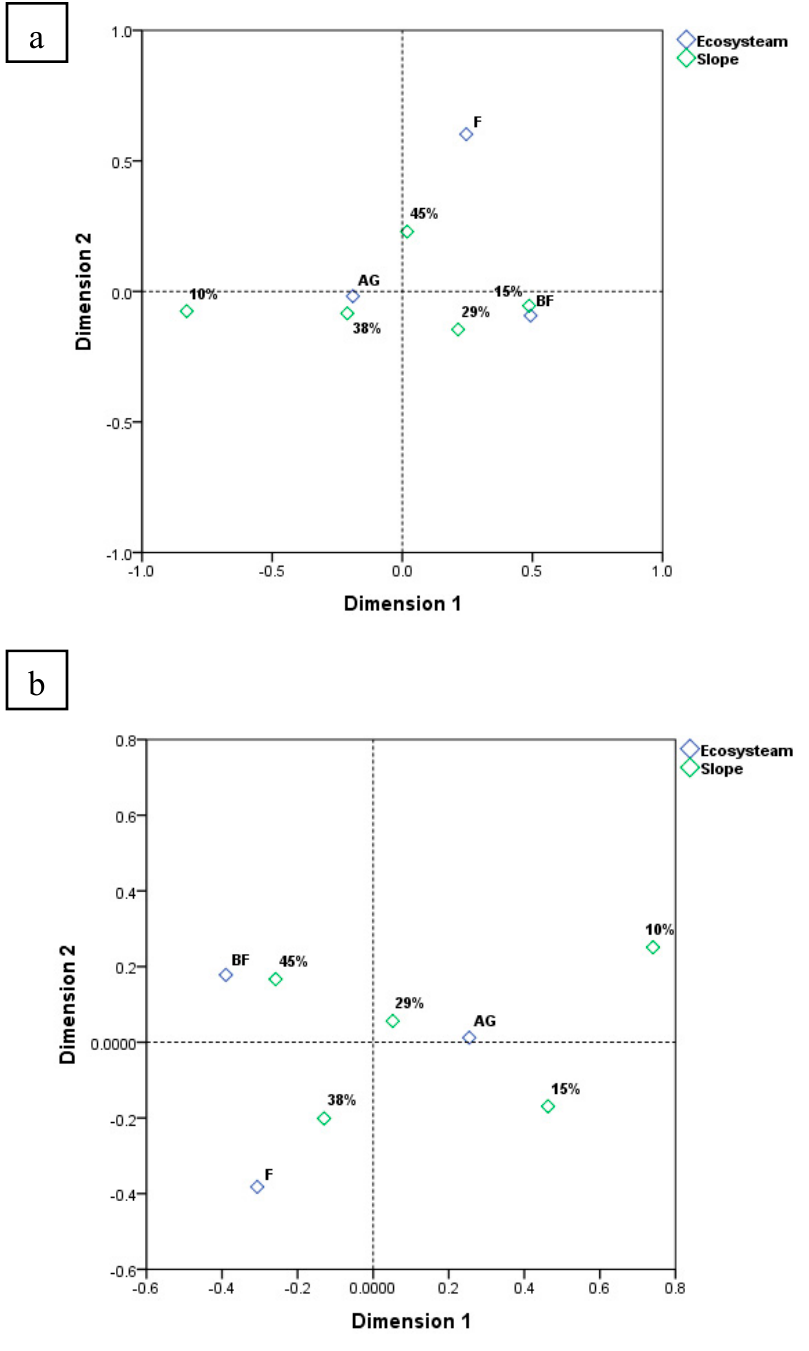
Figure 6. Correspondence analysis per plot: ( a ) soil loss and ( b ) runoff.